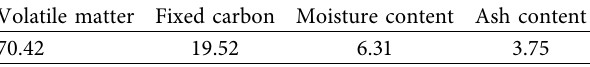
Table 3: Proximate analysis in wt%.